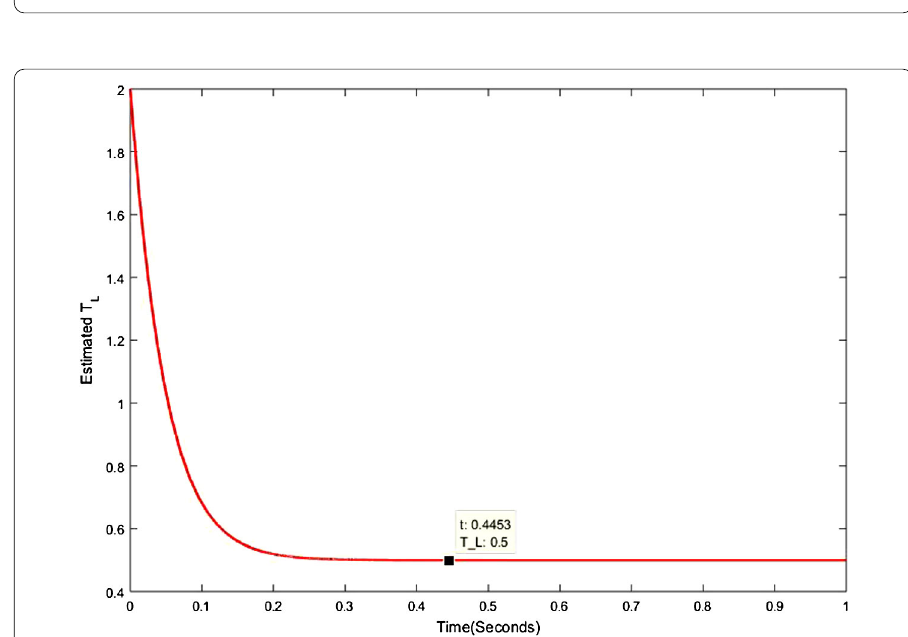
Figure 11 Estimated unknown load values with controller in action at t = 0.1